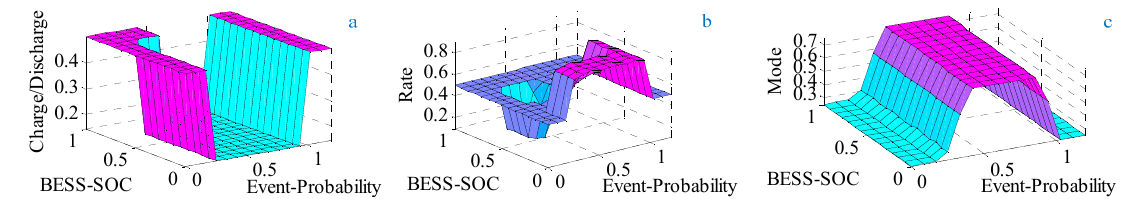
all possible combinations, as shown in Figure 9c.